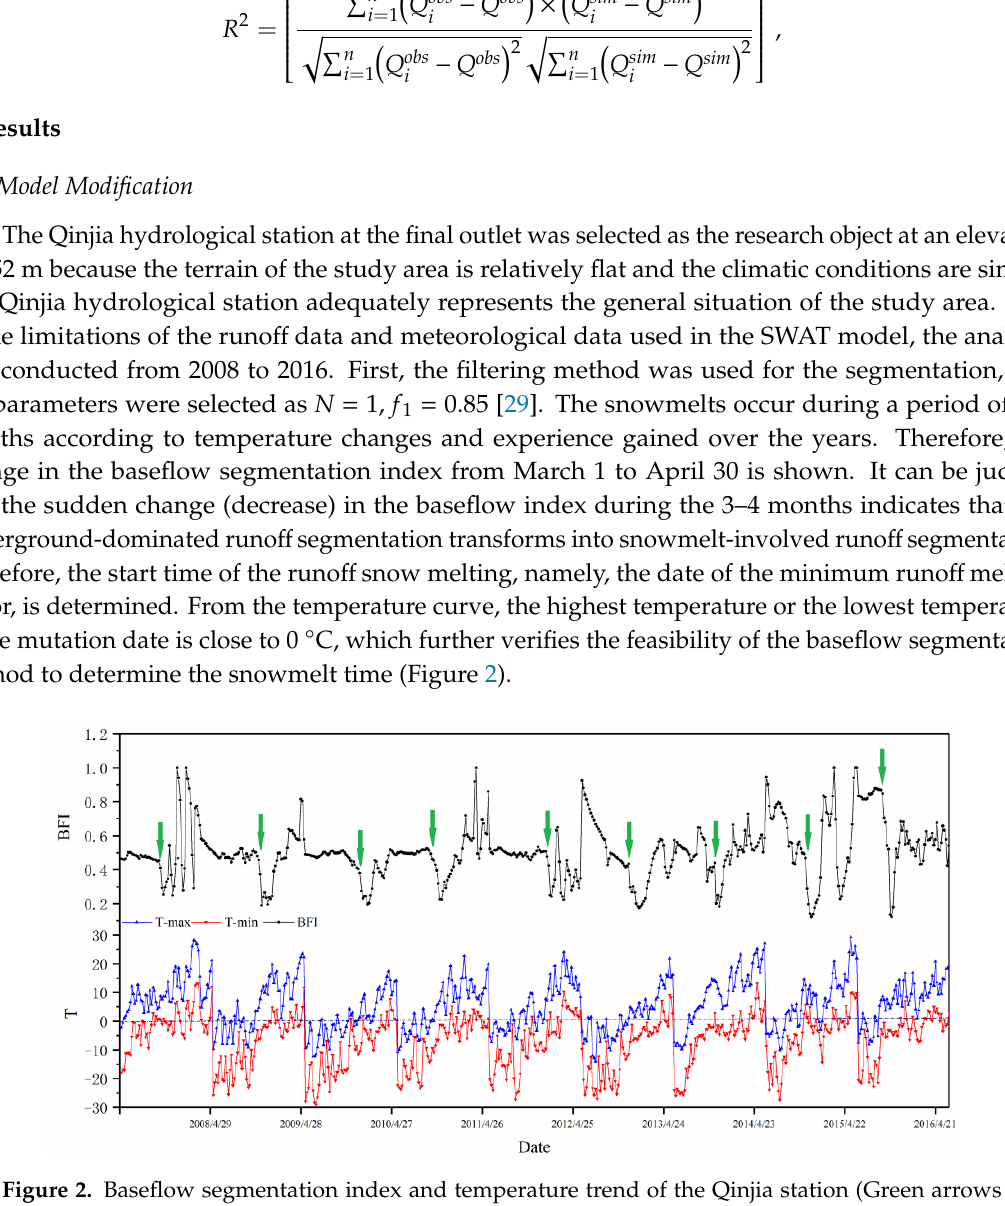
Figure 2. Baseflow segmentation index and temperature trend of the Qinjia station (Green arrows represent snowmelt starting date, T-max is the daily maximum temperature and T-min is the daily minimum temperature ） .